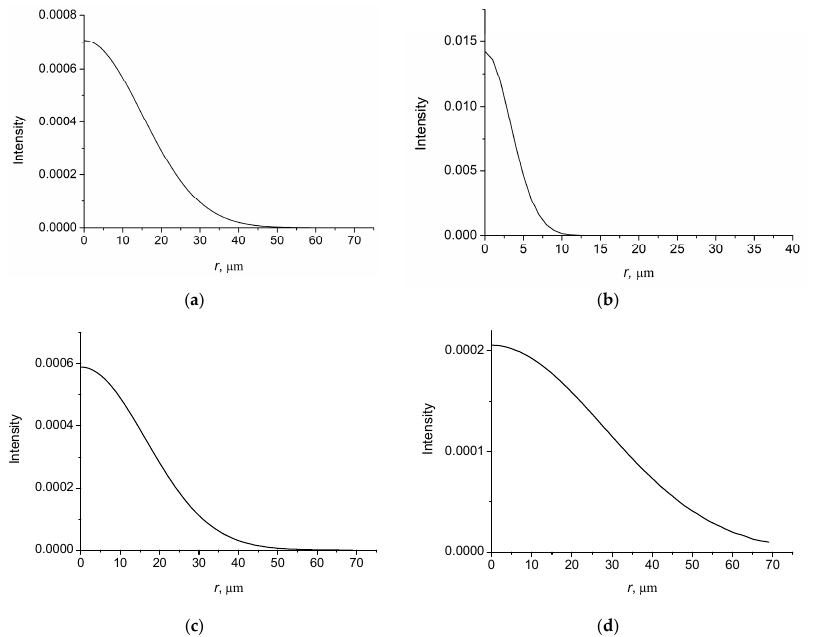
Figure 5. Intensity distributions of Gaussian beam with w = 30 μ m and λ = 0.63 μ m at different distances: ( a ) z = 0; R f = 1000 µ m; ( b ) z = 1000 µ m, R f = 1000 µ m; ( c ) z = 2000 µ m, R f = 1000 µ m; ( d ) z = 2000 µ m, R f = 100,000 µ m.